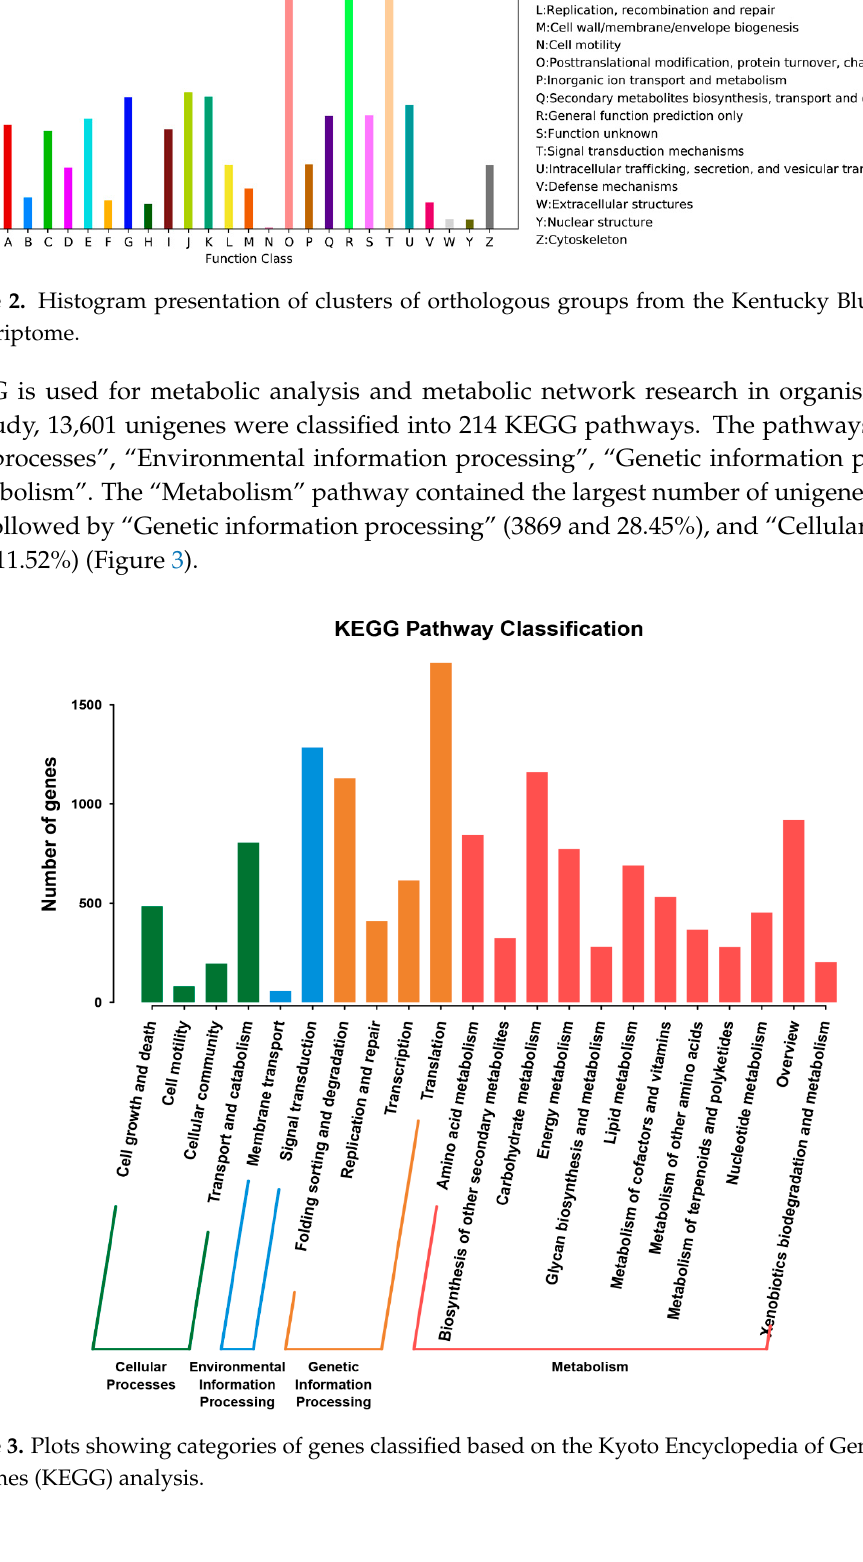
Figure 1. Bar plots of Gene Ontology (GO) classifications of the assembled sequences from the Kentucky Bluegrass transcriptome.